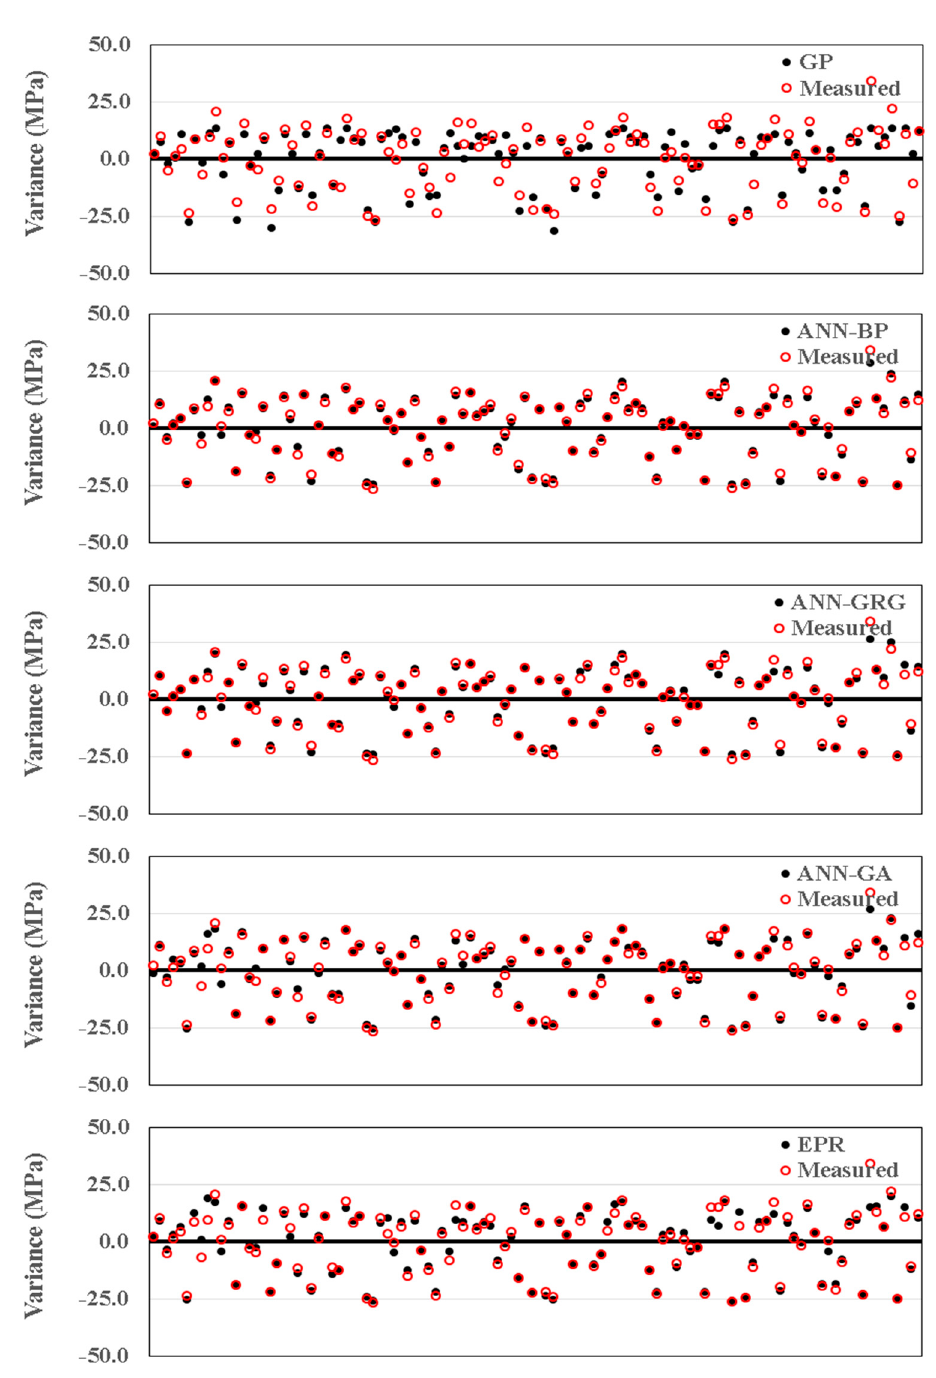
Figure 6. Comparison between developed models for Fc28 using variance diagrams.